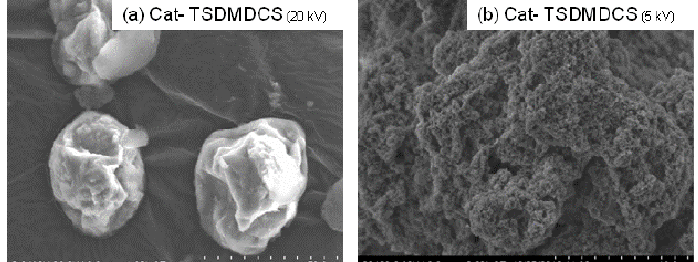
Figure 6. SEM micrograph and elemental distribution on Cat-TSDMDCS; (a) SEM image; (b) external surface; (c) Mg distribution; (d) Si distribution and (e) Ti